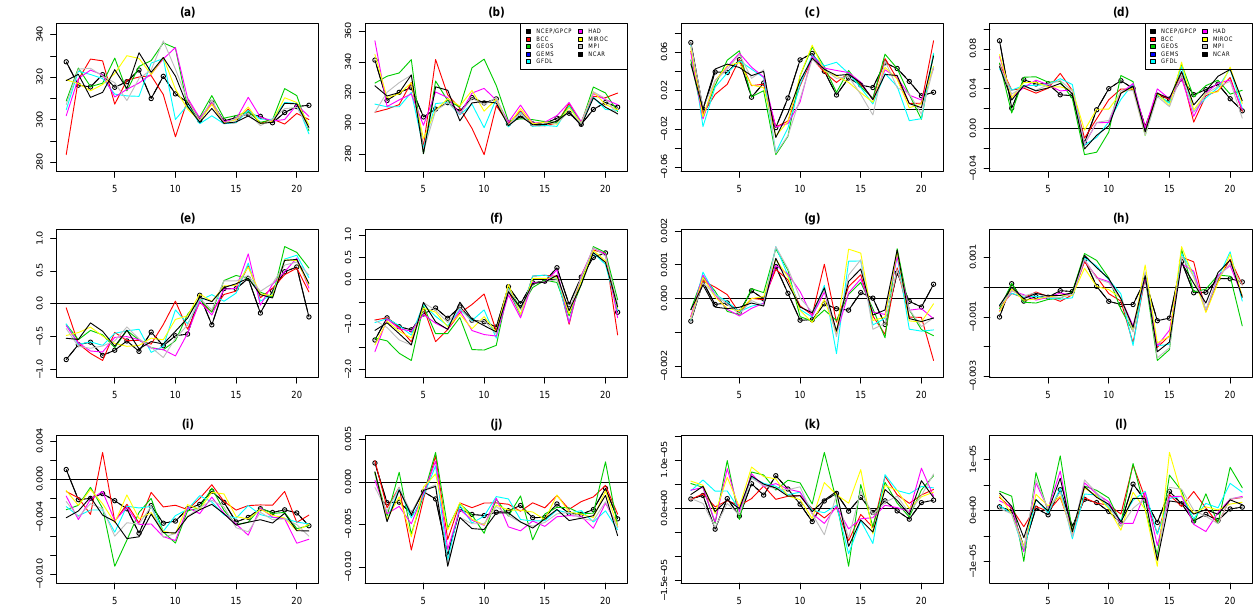
Figure 5. Mean filtering coefficients by region number (land regions only) for temperature intercept (a) JJA and (b) DJF, precipitation intercept (c) JJA and (d) DJF. Temperature latitude coefficient (e) JJA and (f) DJF, and precipitation latitude coefficient (g) JJA and (h) DJF. Temperature elevation coefficient (i) JJA and (j) DJF, and precipitation elevation coefficient (k) JJA and (l) DJF. Plots include results from NCEP/GPCP plus all eight GCMs as separate lines.